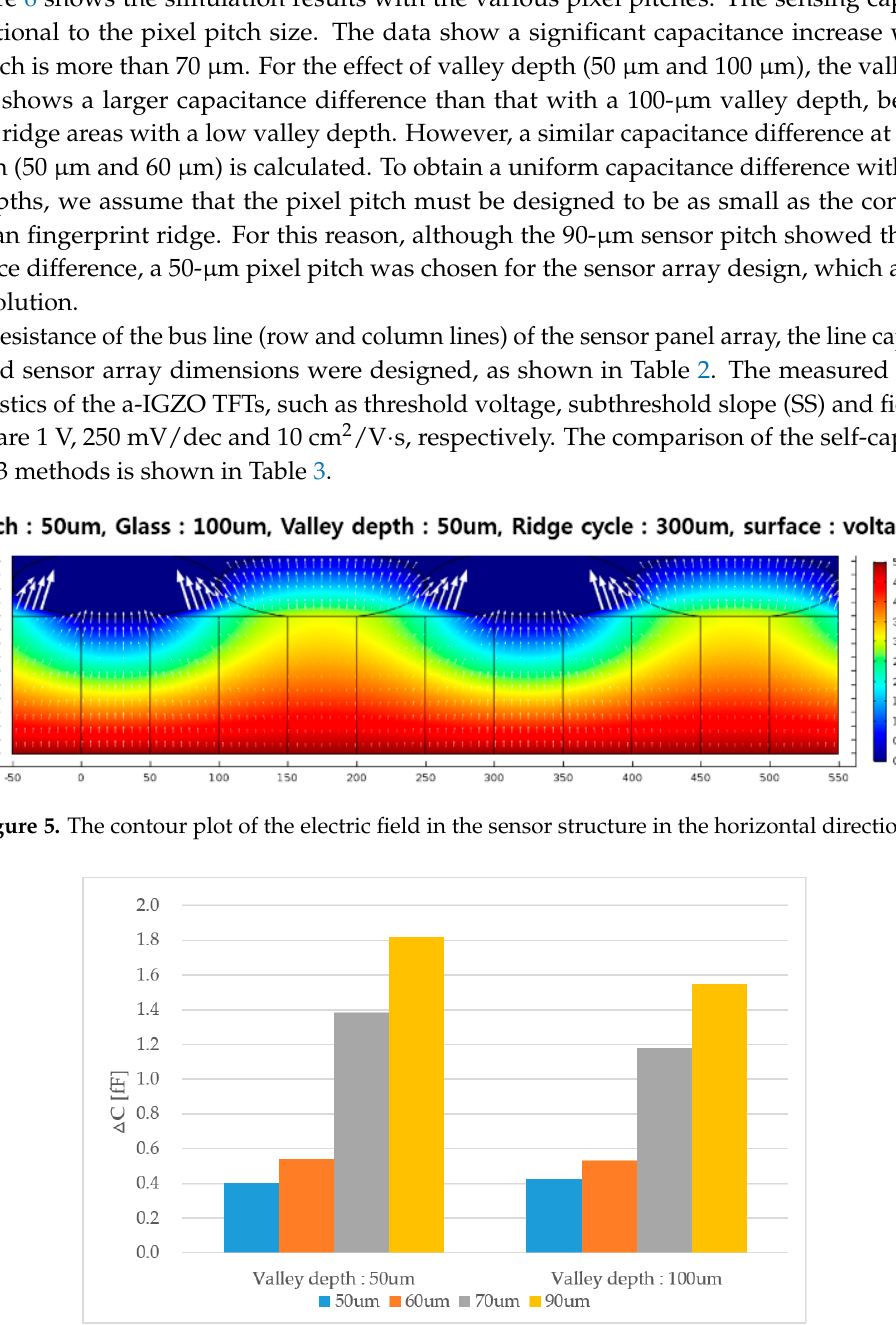
Figure 6. The simulation results on the capacitance difference ( ∆ C) of the ridge to valley region (valley depth: 50 µ m and 100 µ m, ridge pitch: 300 µ m, and the pixel pitch: 50/60/70/90 µ